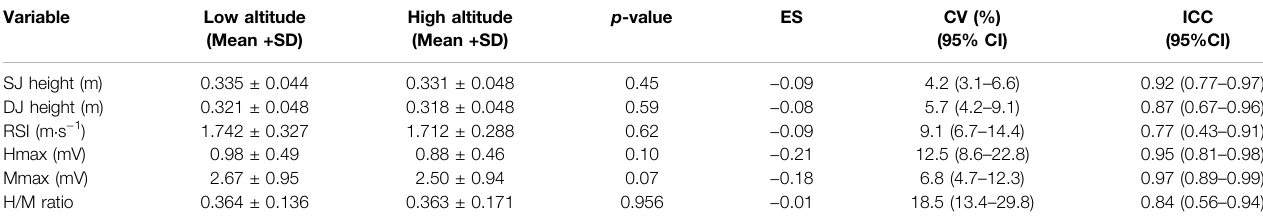
TABLE 1 | Repeatability of the dependent variables obtained by comparing the measurements at 8 h. Variable